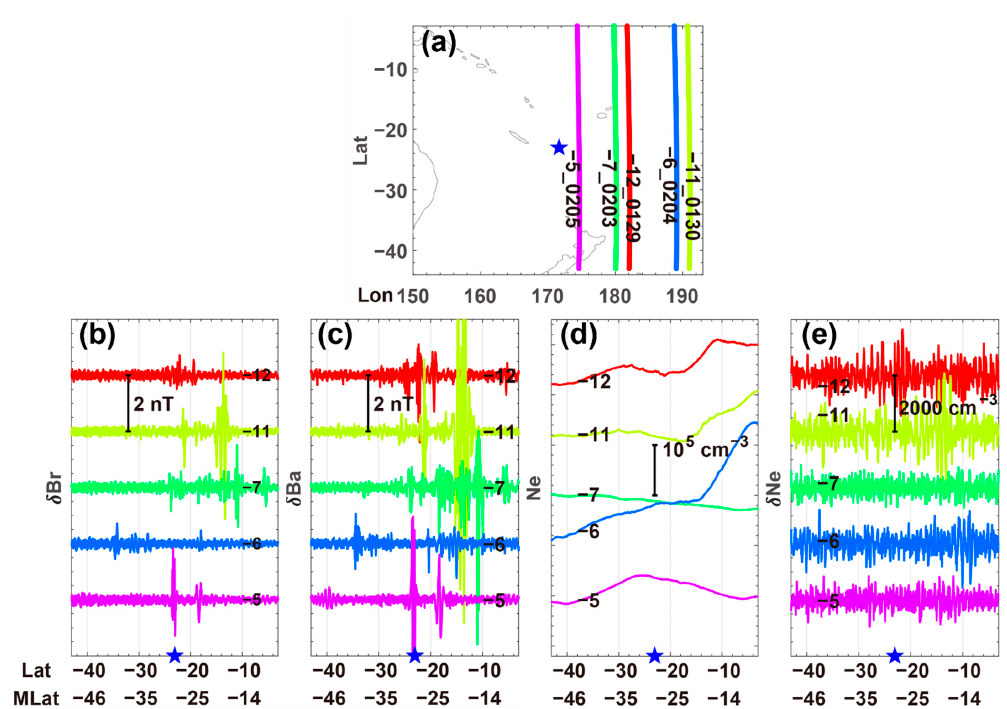
Figure 4. Observations from Swarm A at a similar local time (LT ~18) and on the same day as Swarm B orbits recorded magnetic disturbances. ( a ) Swarm A orbits; the blue star indicates the epicenter; ( b , c ) residual magnetic field in Br and Ba; ( d ) original Ne; ( e ) residual Ne.